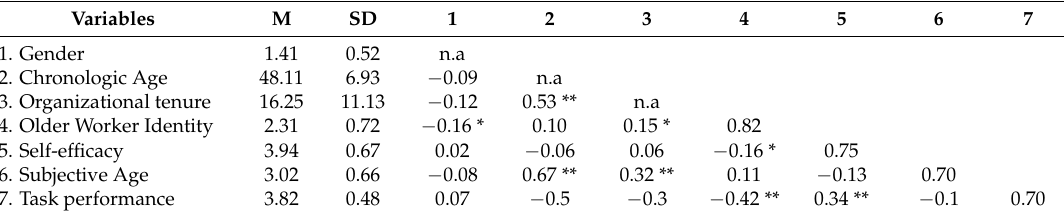
Table 1. Descriptive statistics and correlation matrix. ( n = 200).